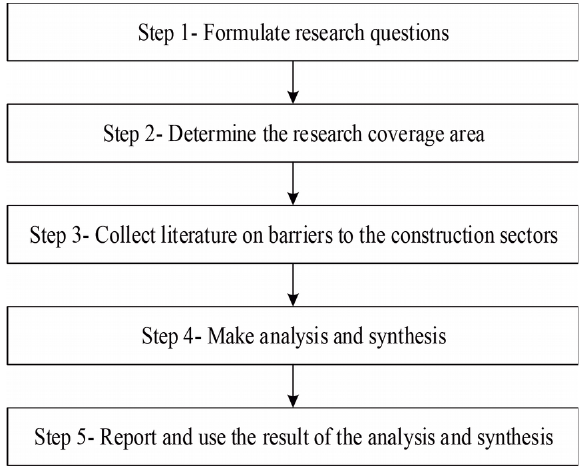
Figure 6. The steps of Literature